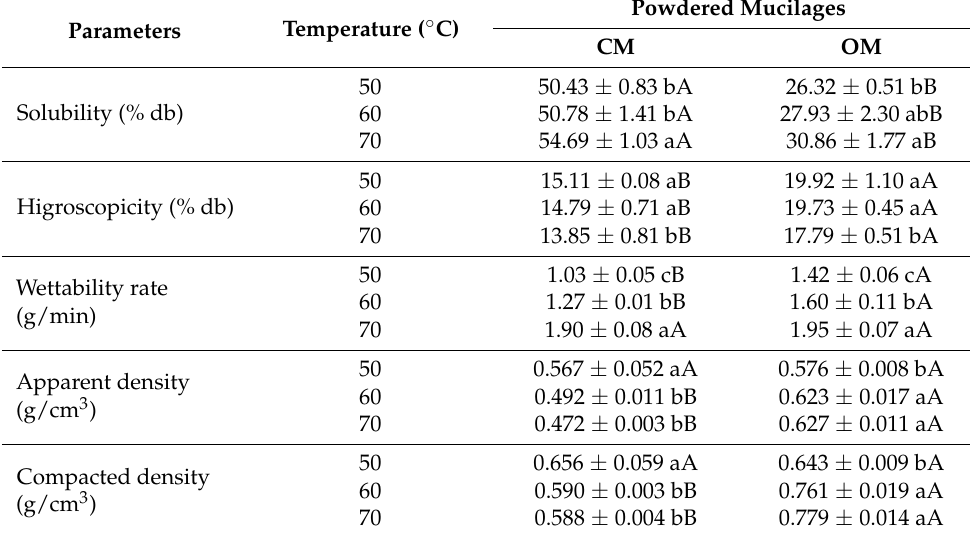
Table 3. Mean values and standard deviations of the physical parameters of mucilage powder from chia (CM) and okra (OM) obtained at different drying